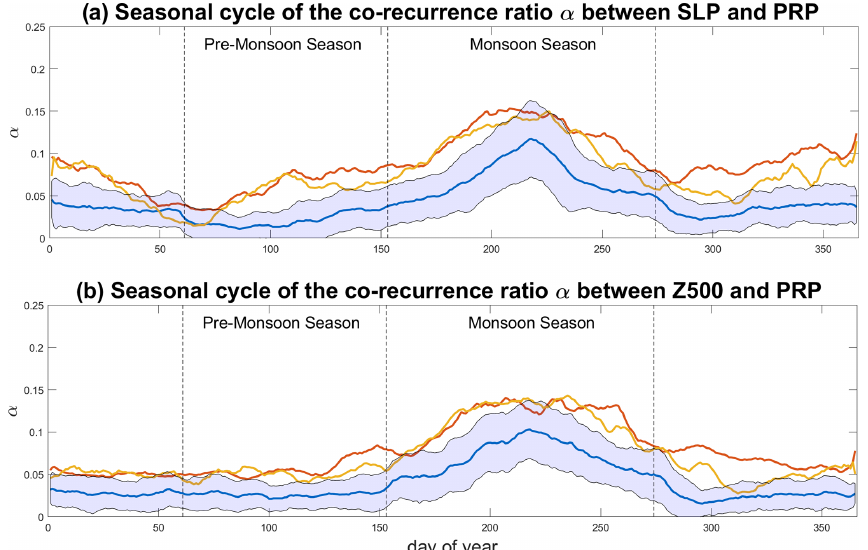
Figure 5. Seasonal cycle of median (a) α SLP , PRP and (b) α Z500 , PRP for the MH CNTL (blue), MH GS+PD (red) and MH GS+RD (orange) simulations. The blue shading marks ± 1 SD from the MH CNTL . The vertical dashed lines mark the pre-monsoon (MAM) and monsoon (JJAS) seasons. The data are smoothed with a 10d moving